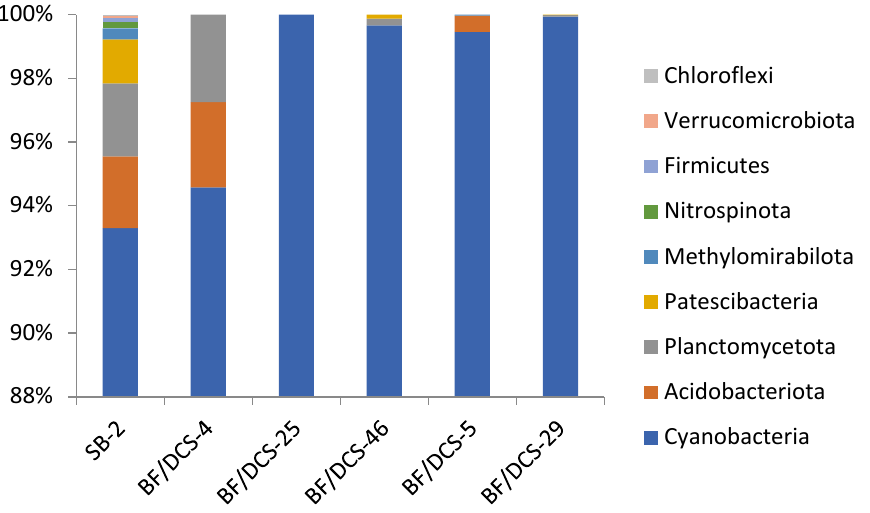
Figure 4. The proportion of cyanobacteria in the microbiome ranges (phyla level) of freshwater bodies feeding the historical fountains of Peterhof: SB-2—Glyadinskoe reservoir; BF/DCS-4—water discharge from the reservoir; BF/DCS-25—waterfall on Simonovskiy stream; BF/DCS-46—Fabrichnaya river; BF/DCS-5—splash area near water discharge; BF/DCS-29—splash area near waterfall; samples designations correspond to Table